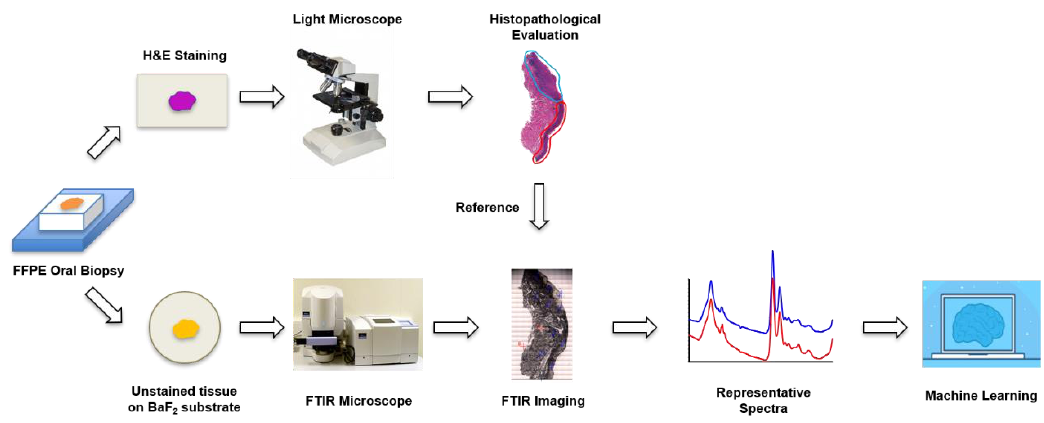
Figure 1. Flowchart of the experiment.